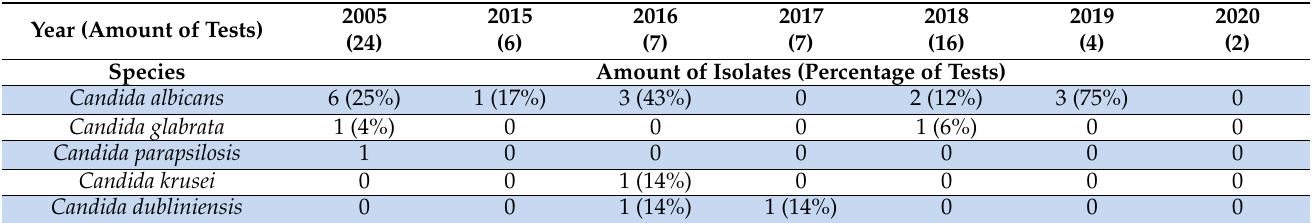
Table 2. Yeast species isolated from the upper respiratory tract in the studied years.